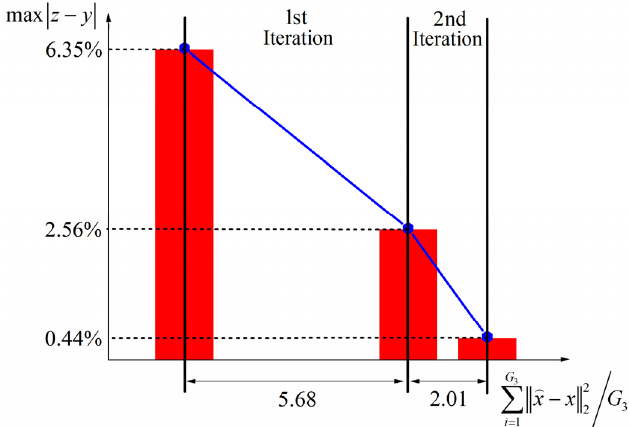
Figure 14. ICM-based adaptation procedure.